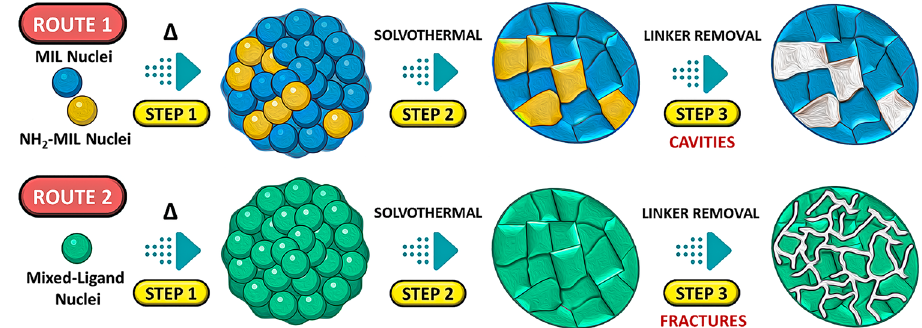
Fig. 9 Mechanistic model of the MOFs formation. Proposed mechanism of the MOFs formation via solvothermal for samples 2-10%NH 2 -MIL and 50-80% NH 2 -MIL, ranging from the formation of amorphous nuclei to crystal with selective